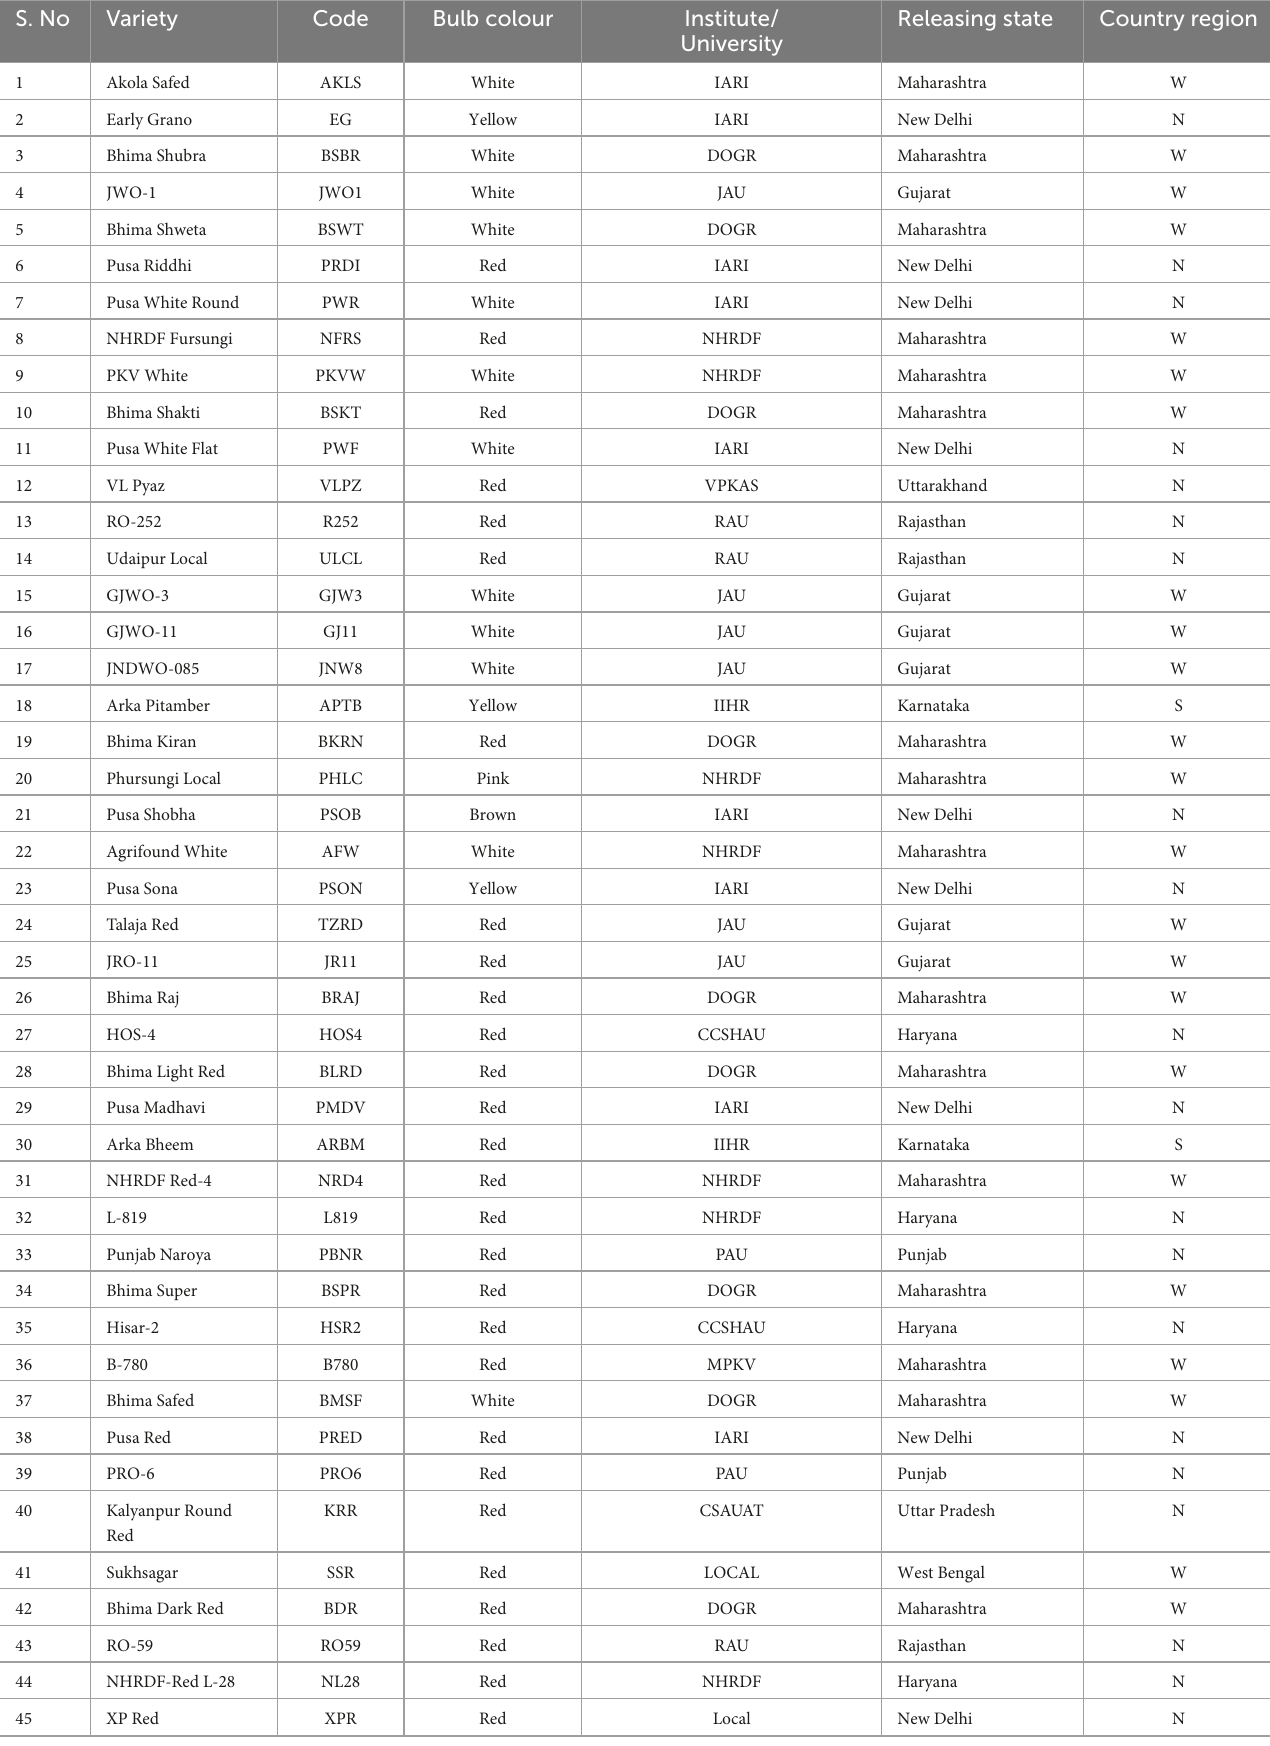
TABLE 1 List of open pollinated short day commercial Indian onion varieties used for assessment of bioactive compounds. S.